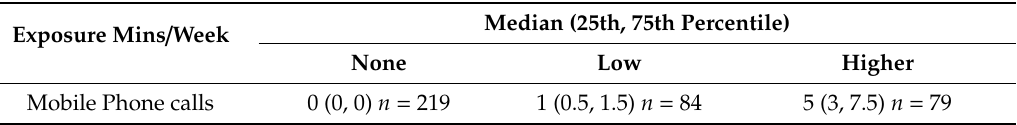
Table 1. Descriptive statistics for mobile phone use in average number of calls made and received per week over a year, as reported by the participant’s parents/guardians.